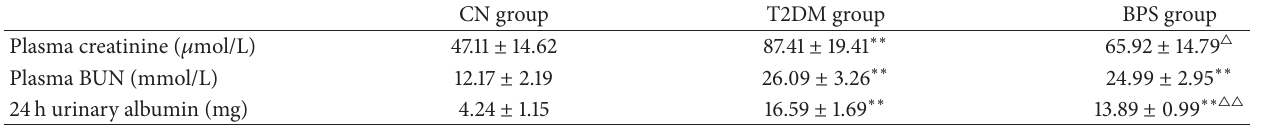
Table 4: Kidney function and 24 h urinary albumin of rats in experiment ( 𝑛 = 6 , 𝑋 ± 𝑆 ).